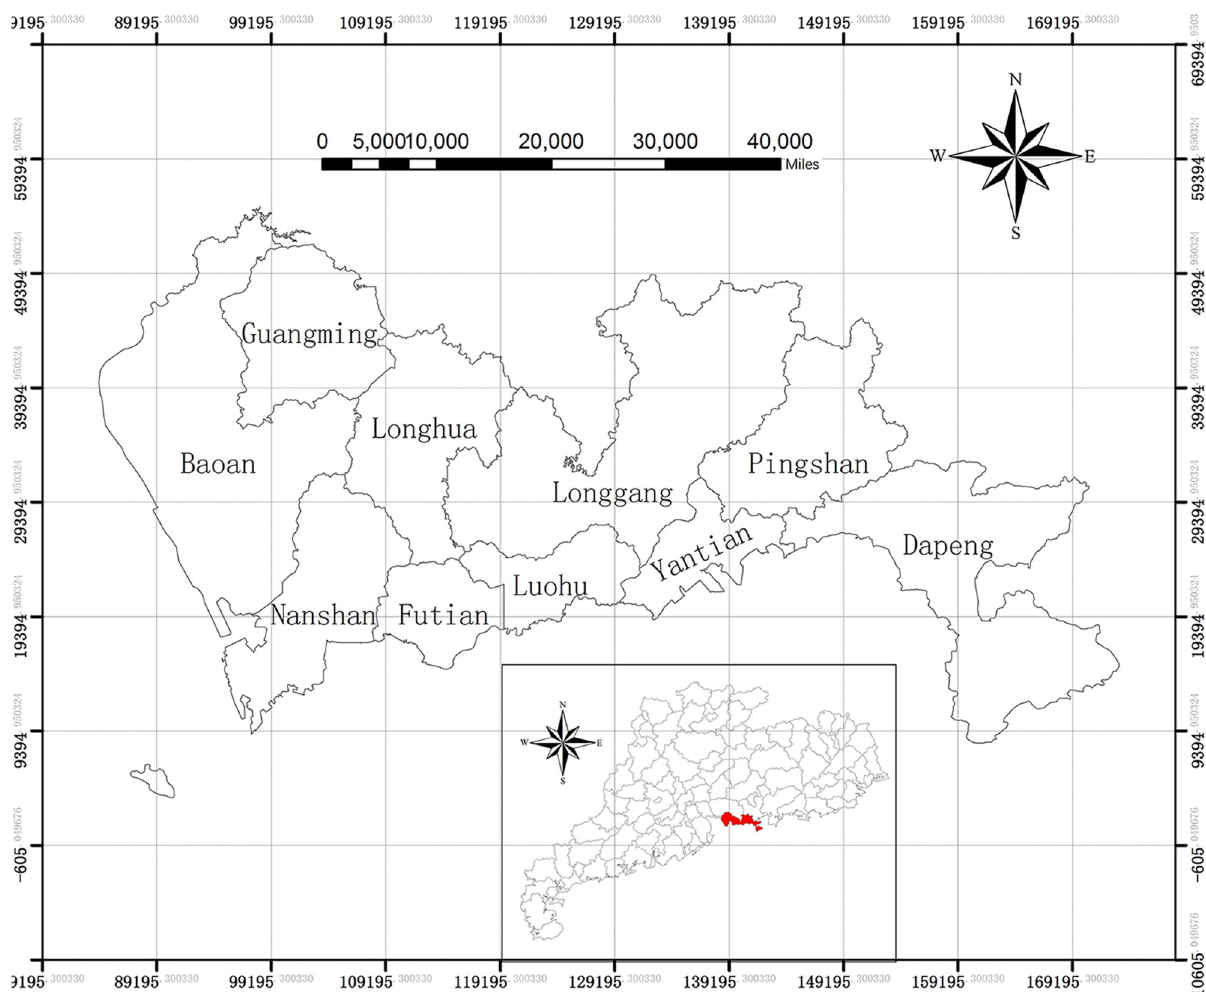
Fig 1. Shenzhen city and its location in Guangdong province. This figure was generated using ArcGIS Geographic Information Systems software version 10.2 (ESRI, USA).